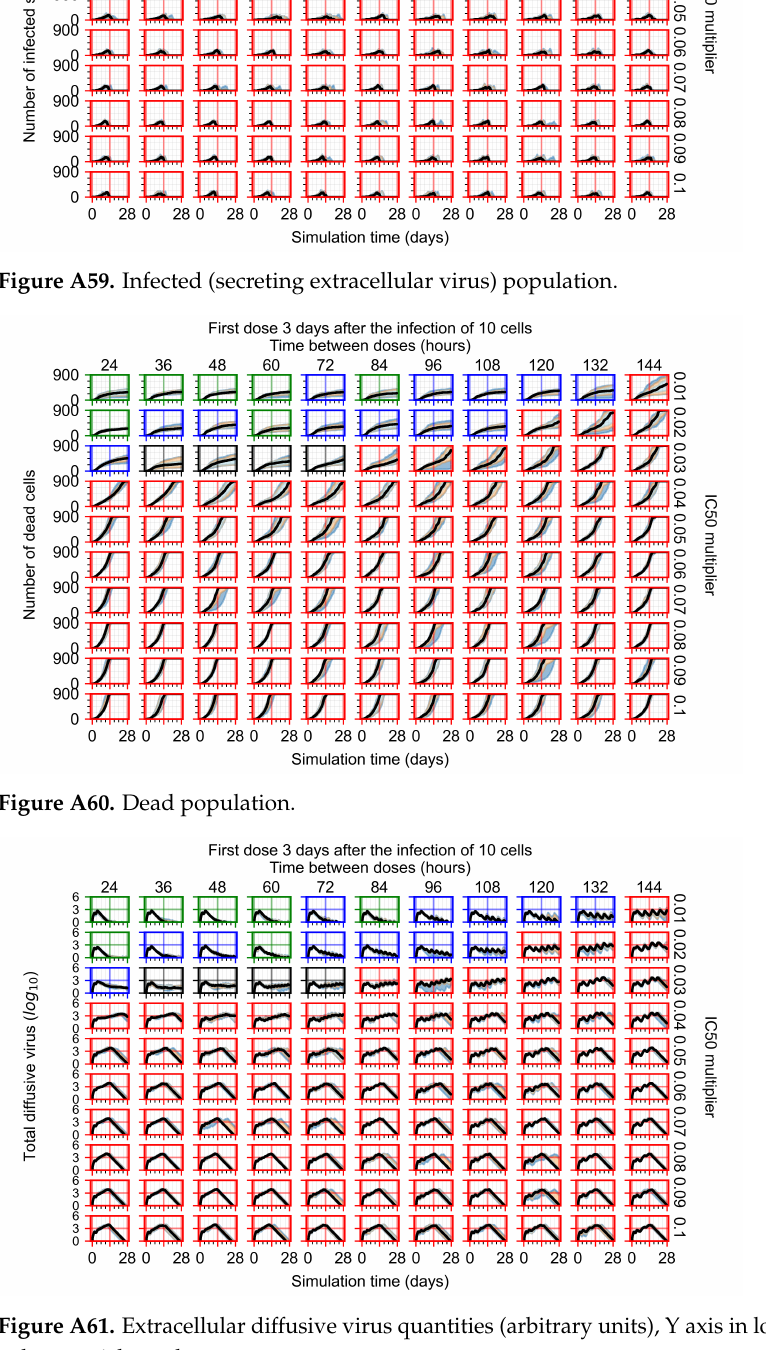
Figure A61. Extracellular diffusive virus quantities (arbitrary units), Y axis in log scale, and exponent values as tick